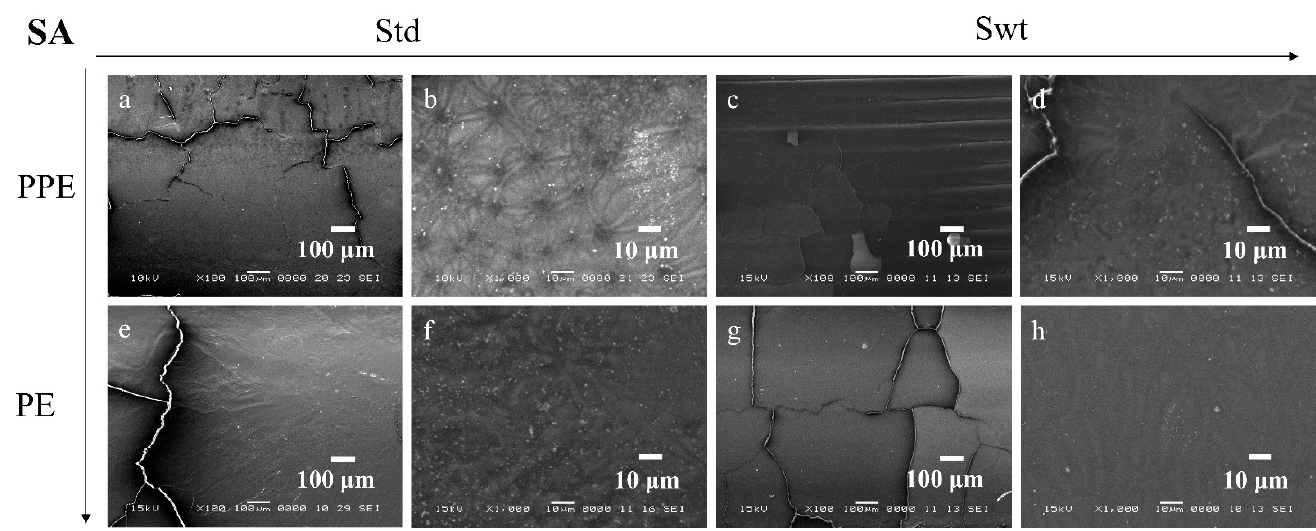
Figure 9. SEM images of SA biofilms in standard ( a , b , e , f ) and switched ( c , d , g , h ) samples on ( a ) ×100, ( b ) ×1000, ( c ) ×100, and ( d ) ×1000 PPE side; ( e ) ×100, ( f ) ×1000, ( g ) ×100, and ( h ) ×1000 PE side of the channel.